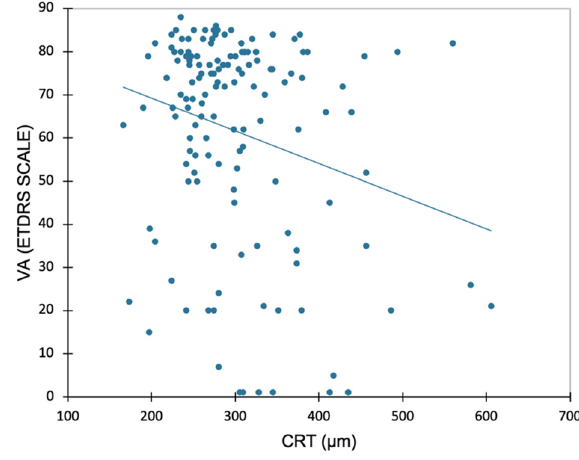
Figure 2. Linear regression plot for visual acuity (VA, ETDRS Scale) and central retinal thickness (CRT) at the study visit. Correlation analysis performed using Pearson’s test (r = − 0.241; p = 0.004).